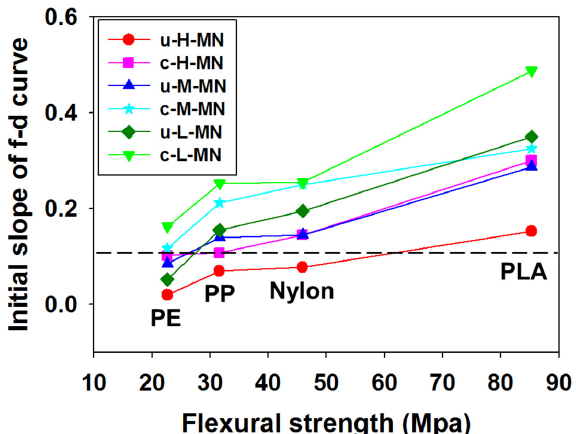
Figure 3. Relation of penetration performance to (1) initial slope of force and displacement, (2) kind of polymer (polyethylene (PE), polypropylene (PP), nylon and polylactic acid (PLA)) and (3) aspect ratio of 3.0, 2.5 and 2.2 for u-MNs and 1.6, 1.4 and 1.3 for c-MNs. Dashed line indicates the 95% puncture performance. Flexural strengths of PE, PP, nylon and PLA are 22, 31, 45 and 85 MPa, respectively.